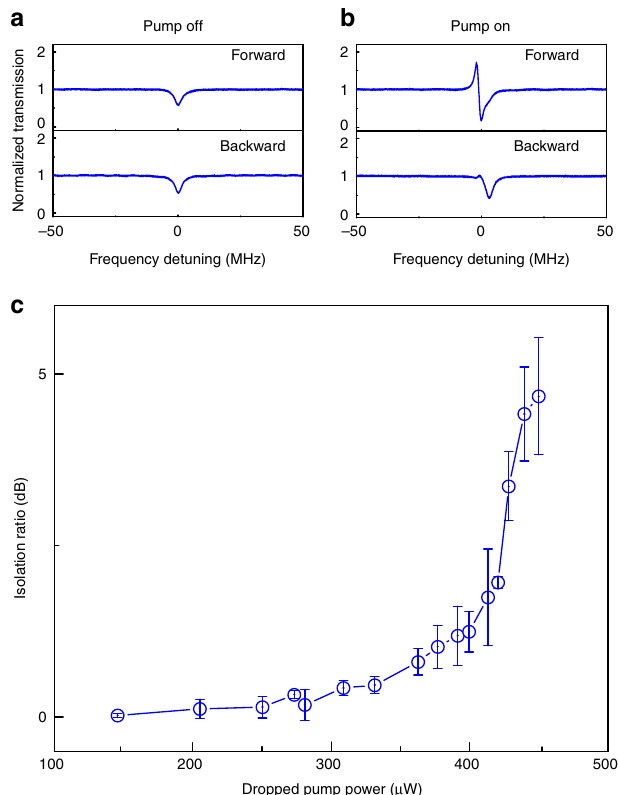
Figure 4 | Optical non-reciprocity versus dropped pump power in the single- fibre-coupling case. ( a ) Reciprocal transmission is expected with pump off. ( b ) With pump on, typical non-reciprocal transmission spectra are recorded as the forward signal experiences phase-matched parametric amplification but the backward does not. ( c ) The optical isolation is characterized only as a function of the dropped pump power. The error bars represent the standard deviations of measured isolation uncertainties under the same conditions, and their fluctuations are mainly affected by the uncertainties of backward signal transmission. Parameters: the simultaneously injected forward and backward signal powers are equal to 1.46 m W and k 1 ¼ 2 p (cid:2) 0.4MHz.